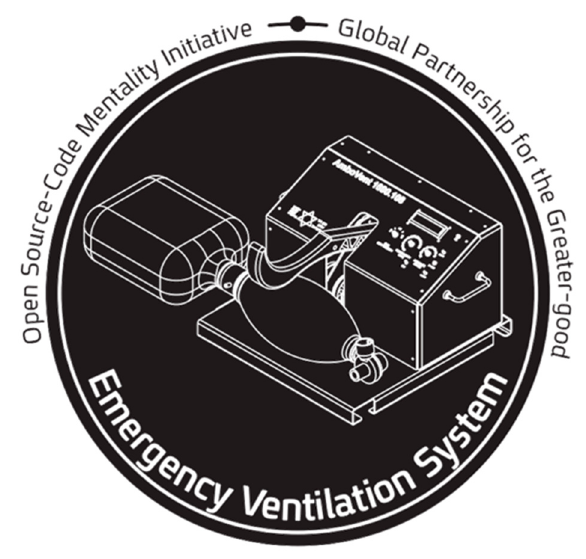
Figure 1. Ambovent, an open source ventilator system logo stressing the need for an open source mentality.